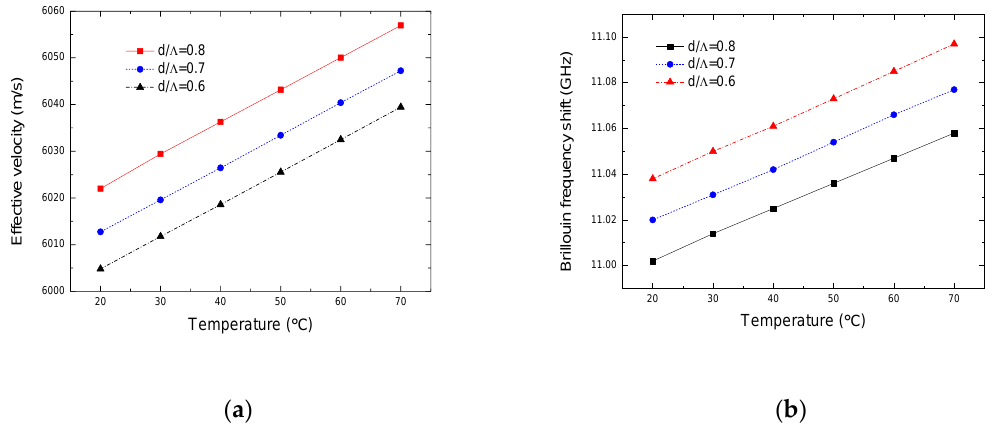
Figure 6. ( a ) the effective velocity ( b ) the Brillouin frequency shift vary with temperature.